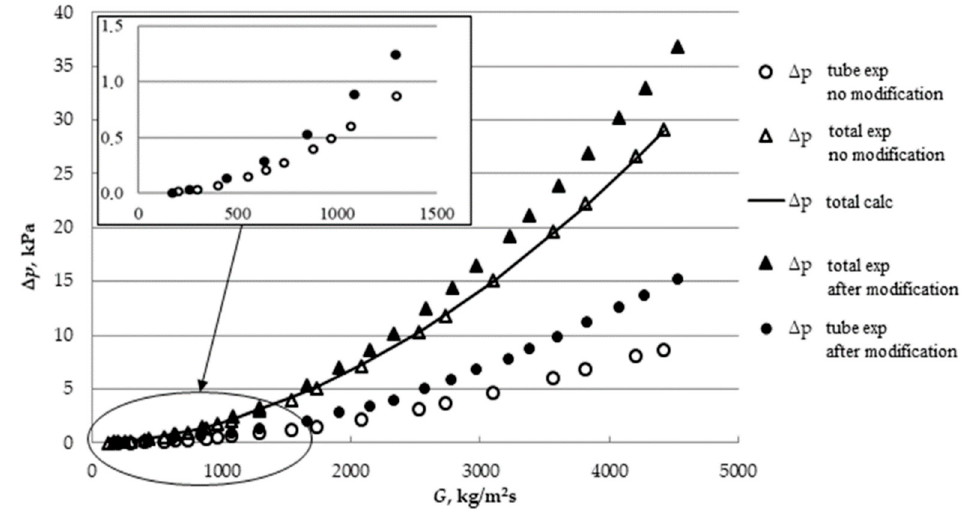
Figure 4. Pressure drop versus mass flow rate.